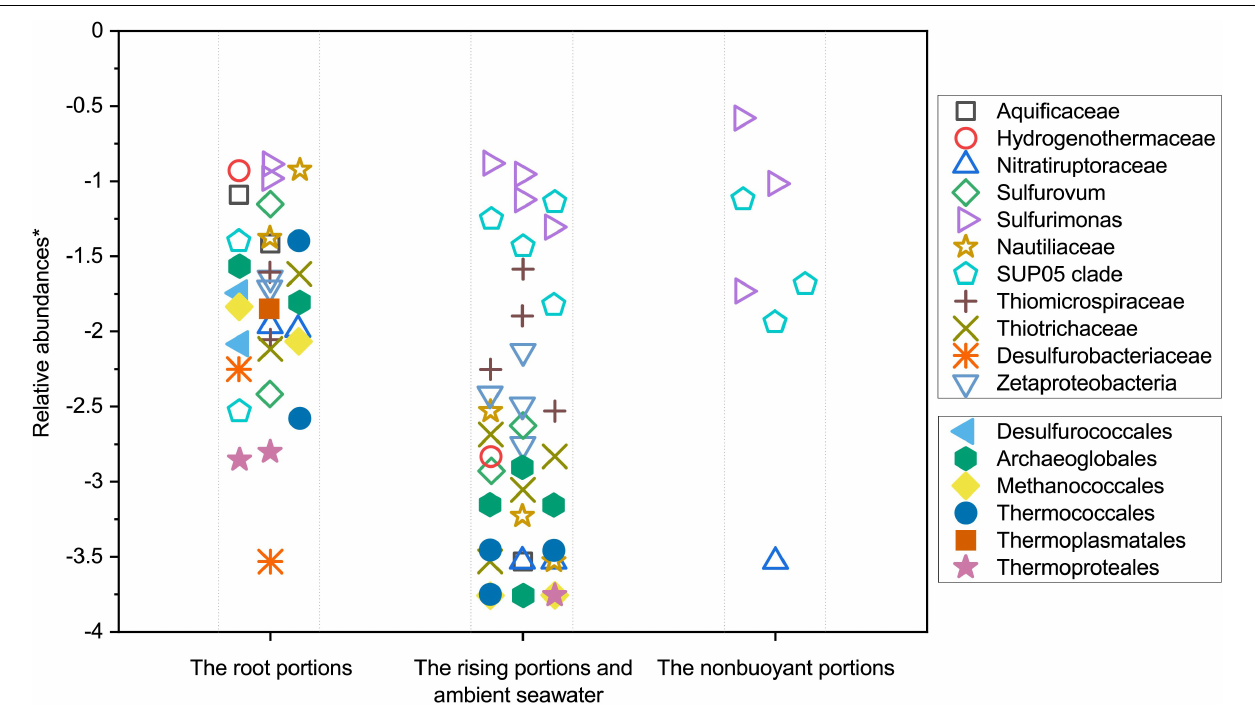
FIGURE 7 | Variation in relative abundances of typical vent-derived and plume-specialized lineages among the different stages (root, buoyant, and non-buoyant) of hydrothermal plumes roughly corresponding to the increasing distances from the vent origin. ∗ The values were calculated by taking the log of the relative